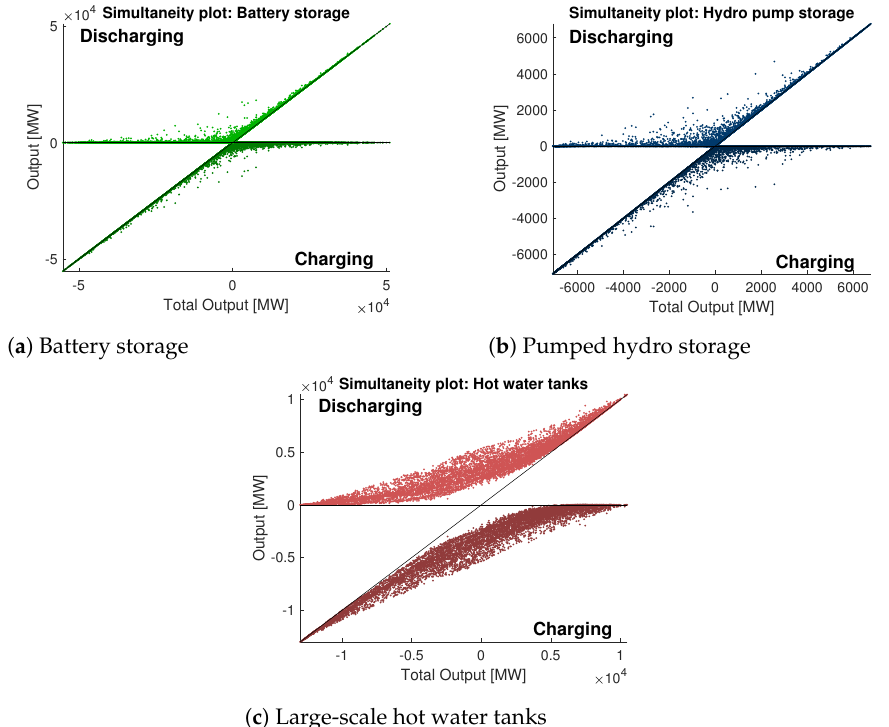
Figure 18. Simultaneity of storage operation in scenario BOTH. The shown patterns do not vary significantly per scenario, only the magnitude of heat storage changes according to scenario.